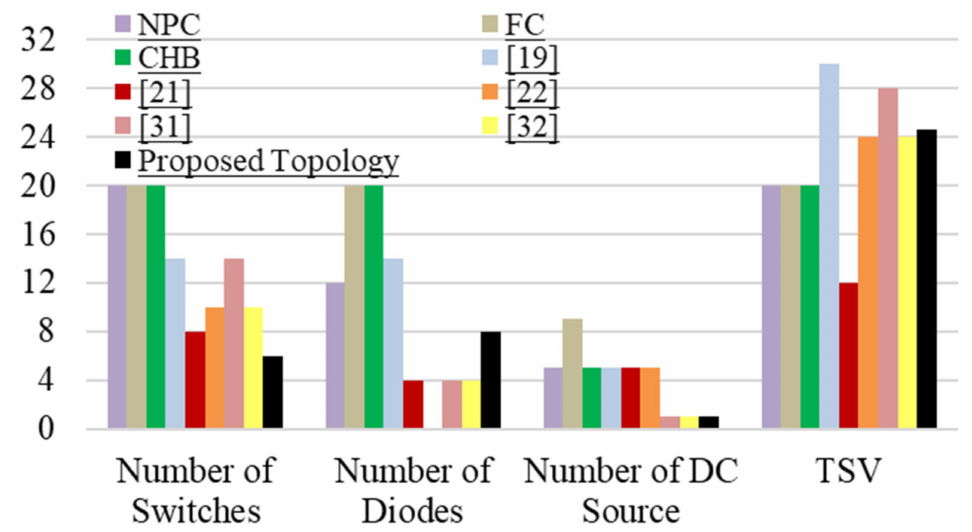
Figure 5. Comparative studies: The number of switches, number of diodes, number of sources and TSV, in terms of the number of